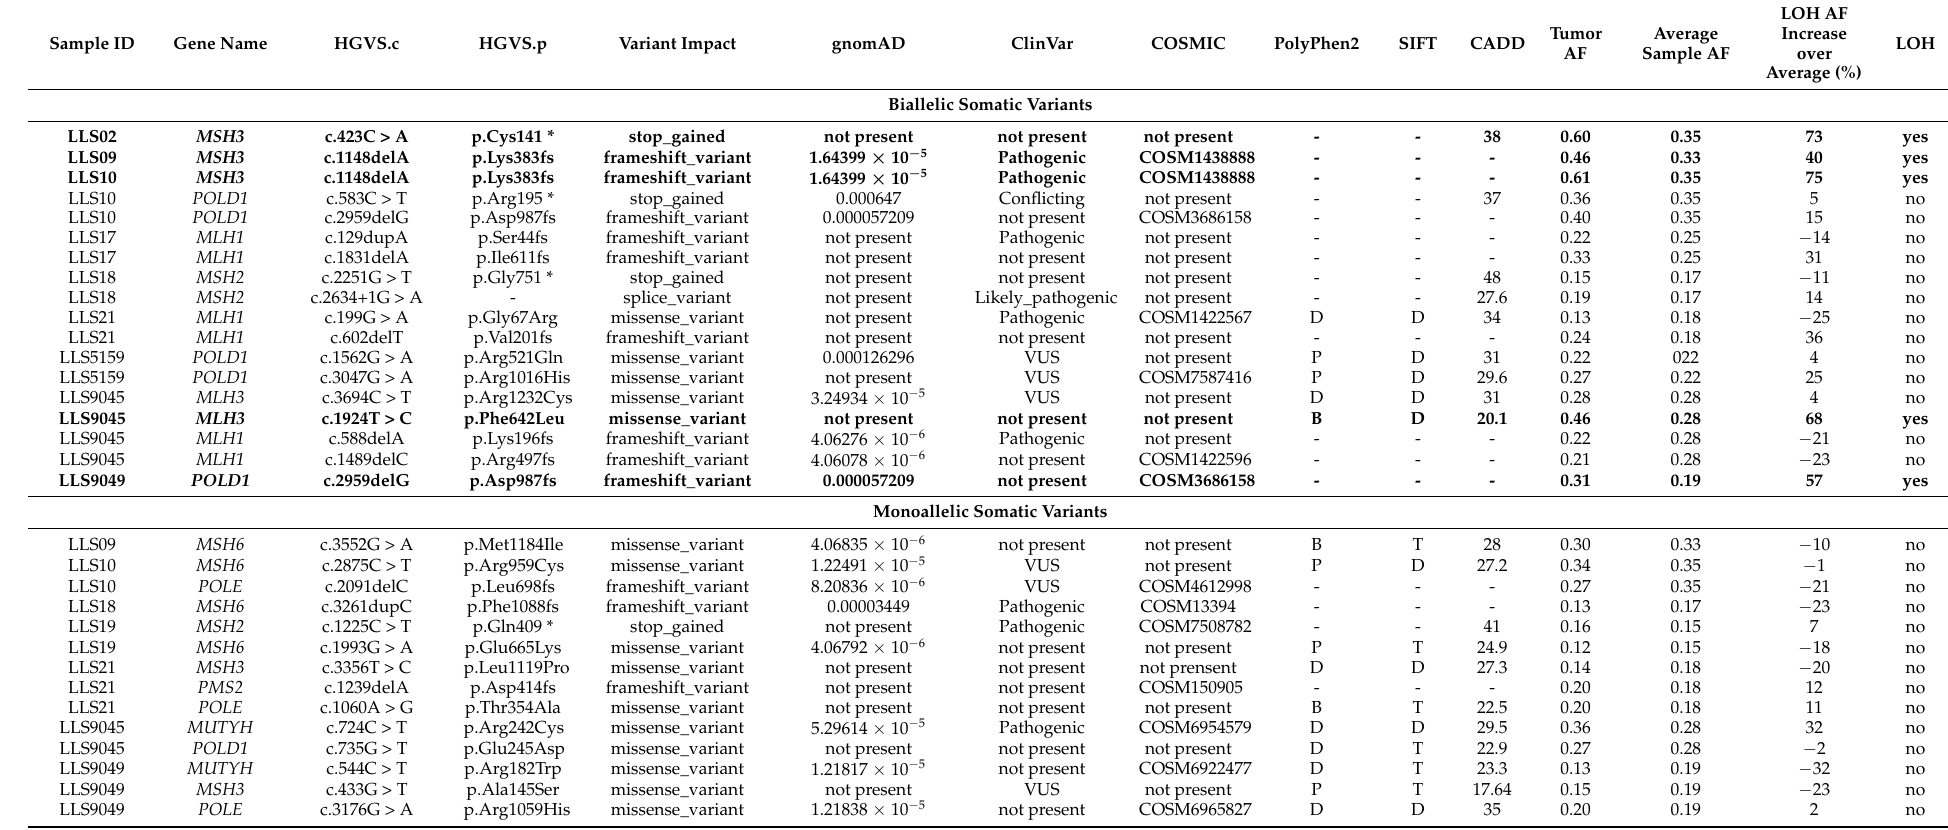
Rows in bold are showing when LOH is associated. GnomAD: allele frequency from gnomAD database. PolyPhen2: B: benign; P: probably pathogenic; D: deleterious; SIFT: T: tolerable; D: deleterious. Tumor AF: alternative allele frequency. Average AF: average of all exome variants over 0.1 of AF. LOH loss of heterozygosity. CADD: Phred score version 1.6. VUS: variant of uncertain significance. HGVS.c: coding variant. HGVS.p: protein level variant. * stop gained